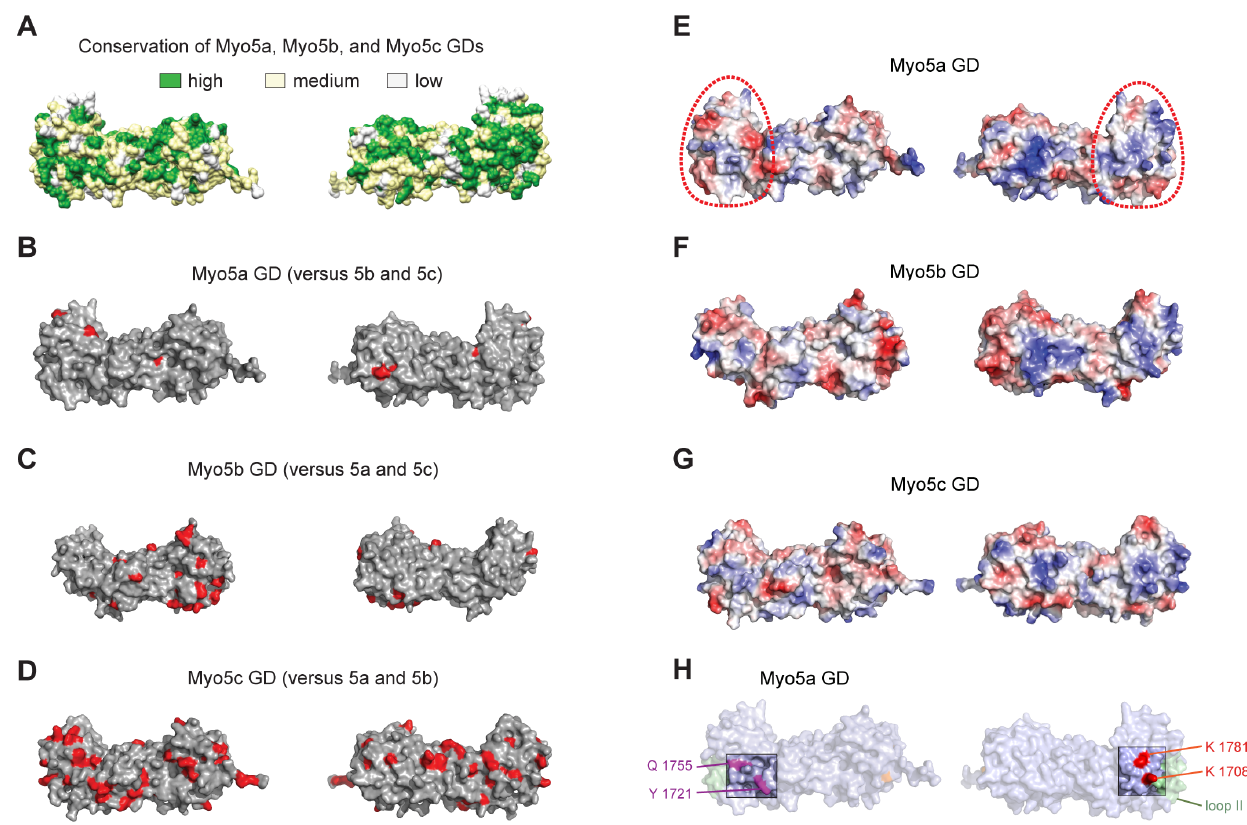
Figure 2. Analyses of surface properties of the globular domains from Myo5a, Myo5b, and Myo5c. Orientation is as shown in Figure 1D (left) and rotated by 180 u around the vertical axis (right). ( A ) Amino acid conservation between human Myo5a, Myo5b, and Myo5c GDs based on alignment shown in Figure S3 in File S1 and plotted on the structure of Myo5a GD. Green indicates high sequence conservation, yellow partial conservation, and white a lack of conservation. ( B–D ) Unique surface residues in Myo5a (B), Myo5b (C), or Myo5c (D), when compared to their respective paralogs, are shown in red. ( E–G ) Representation of surface potentials of Myo5a (E), Myo5b (F), and Myo5c (G). Red and blue indicate surface areas with negative and positive surface charges, respectively. White regions indicate hydrophobic regions. The surface region encircled by a red dotted line is an area with high similarity of overall surface charges amongst the three type V myosins (see also Figure S6 in File S1). This similarity might hint at a common function in all three paralogs. ( H ) Amino acids required for Rab11a binding are highlighted in magenta, residues in red are essential for motor autoinhibition.